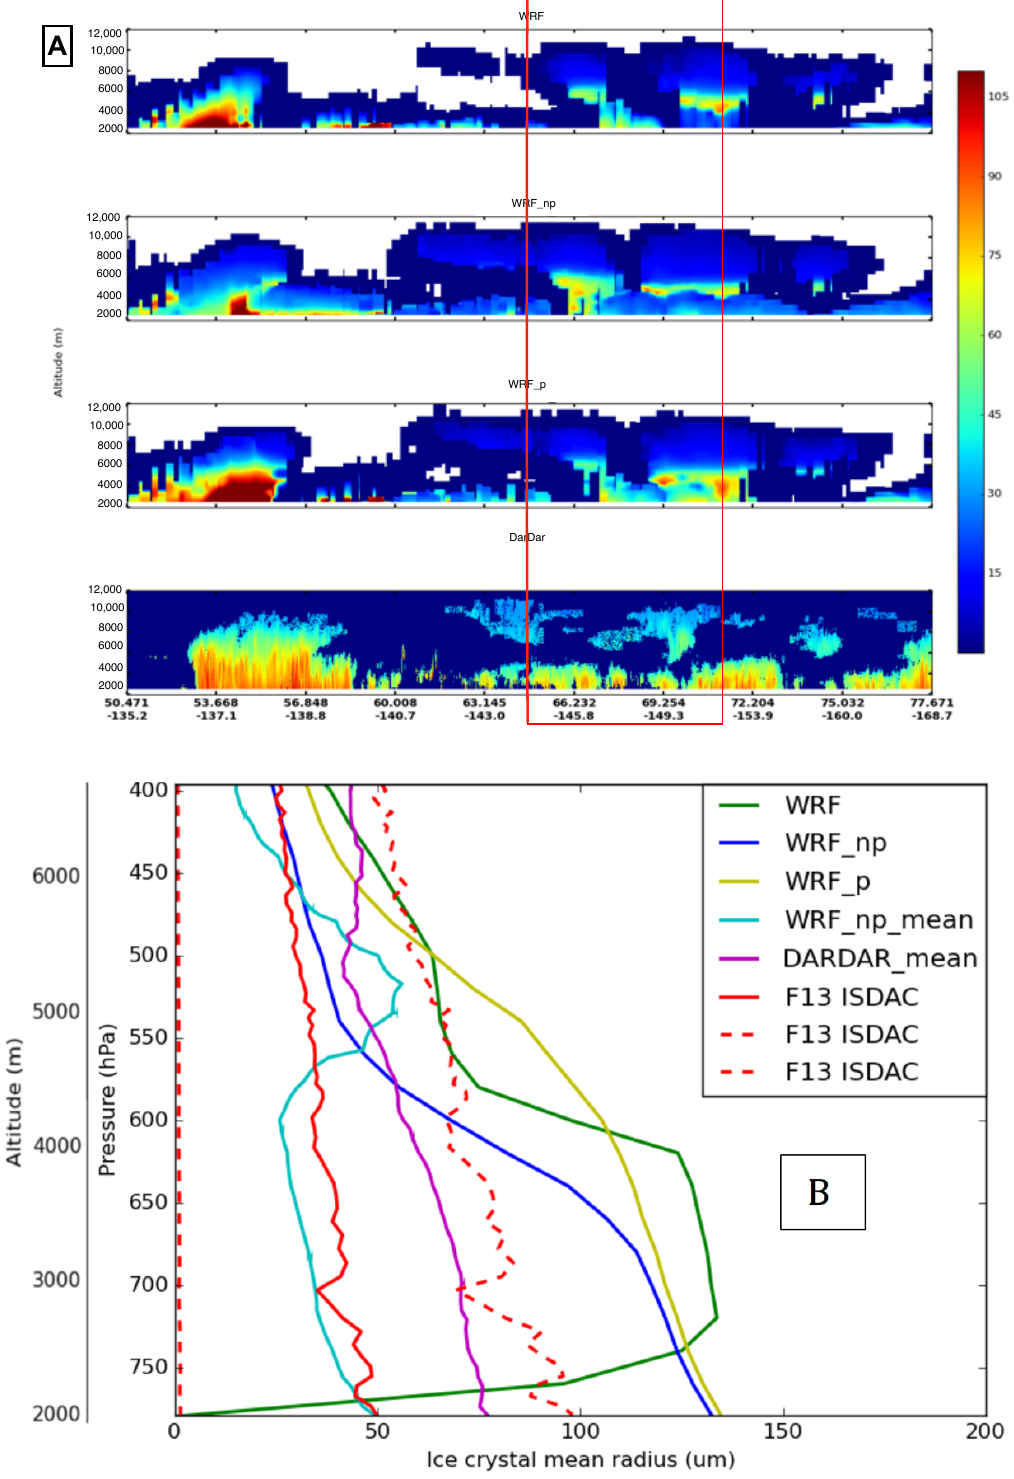
Figure 11. Observed and simulated (WRF, WRF_np and WRF_p) Ri along T13 track ( A ) and F13 flight ( B ). Simulated profile WRF_np_mean averaged along the satellite track over the larger domain of Figure 1 is also shown on ( B ) together with DARDAR-retrieved average profile. The dashed red line on ( B ) represents the variability (standard deviation) of ISDAC